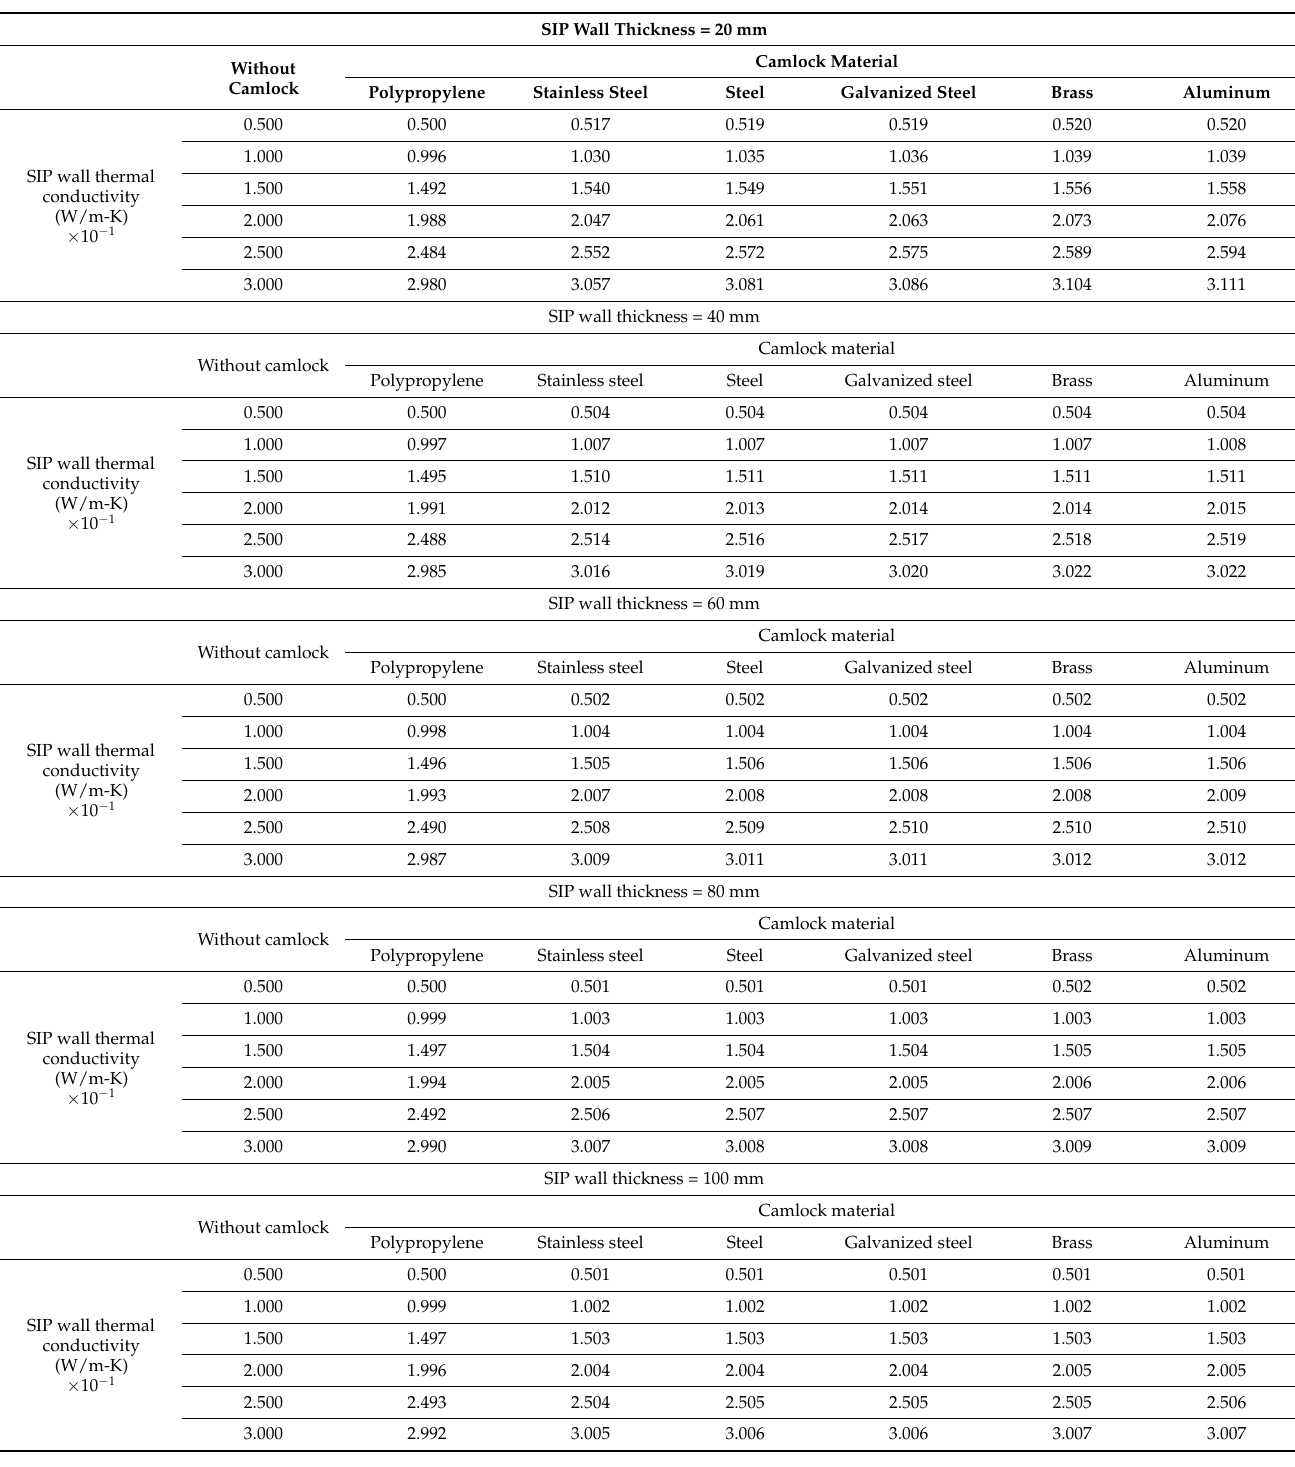
Table 3. Thermal conductivity of the SIP wall with different camlock materials, SIP thermal conduc- tivities, and wall